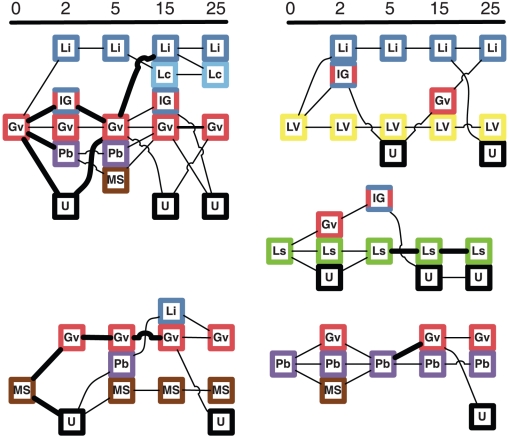
Changes in microbiota profile after antibiotic intervention.The network depicts the profile of the vaginal microbiota before (time  = 0) and after metronidazole intervention. A thin line represents one subject while a thick line represents two. Only women were included with a complete follow-up and when a microbiota was present similar to the major profiles at baseline (Figure 1). Gv indicates G. vaginalis, MS =  Multiple species, LV =  Lachnospiraceae & Veillonellaceae, Ls =  Lachnospiraceae, Pb =  P. bivia and U =  minor clusters.